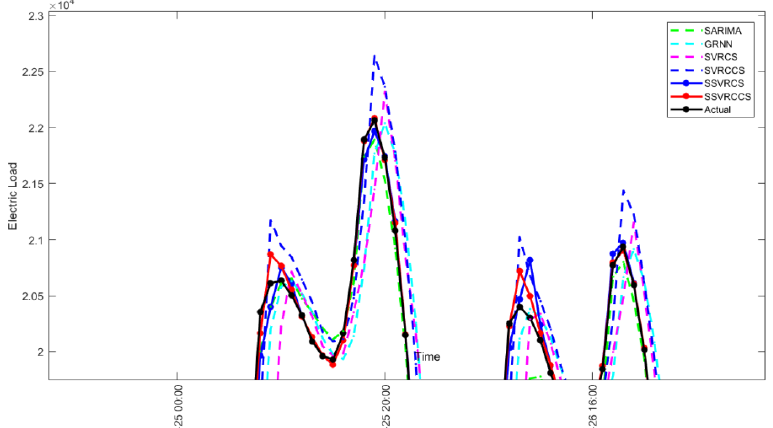
Figure 11. The enlargement comparison of Peaks 1 and 2 from the compared models for Example 2.